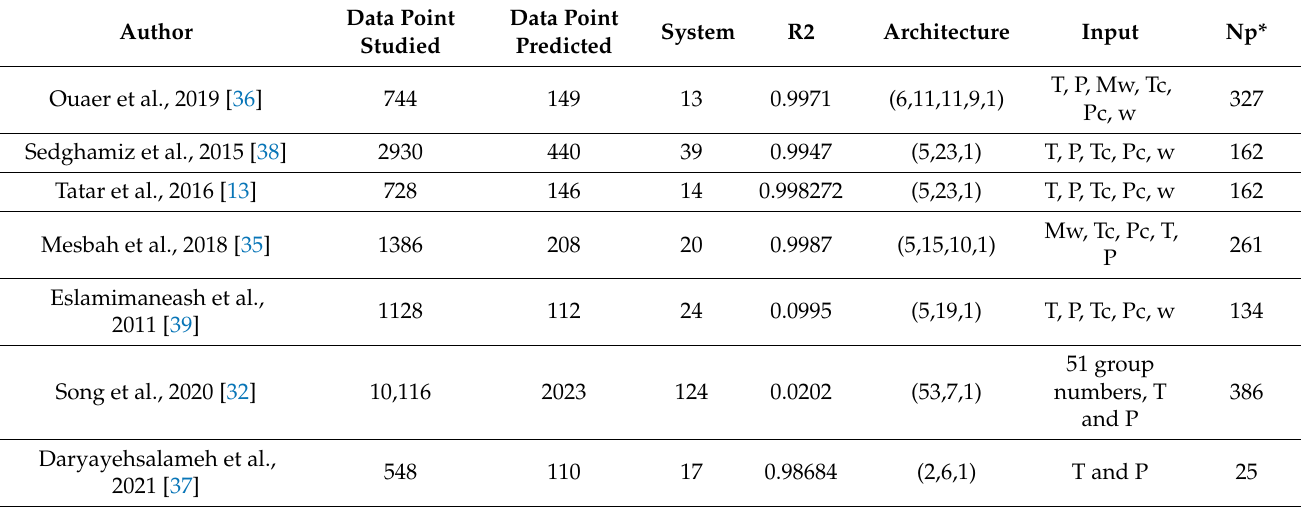
Table 1. Detail of some models reported to predict the solubility of binary mixtures composed of CO 2 and ILs using an